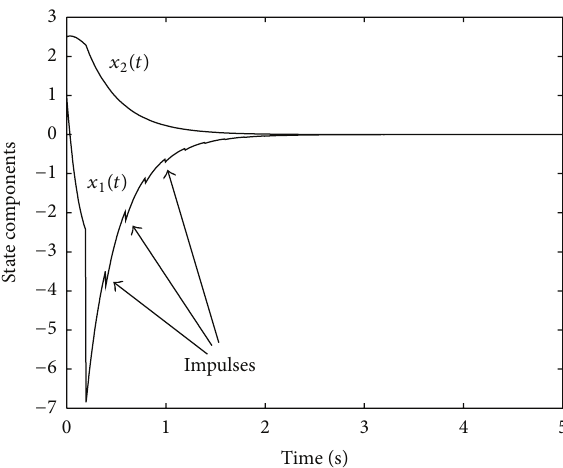
Figure 11: Evolution of the state component 𝑥 1 (𝑡) .